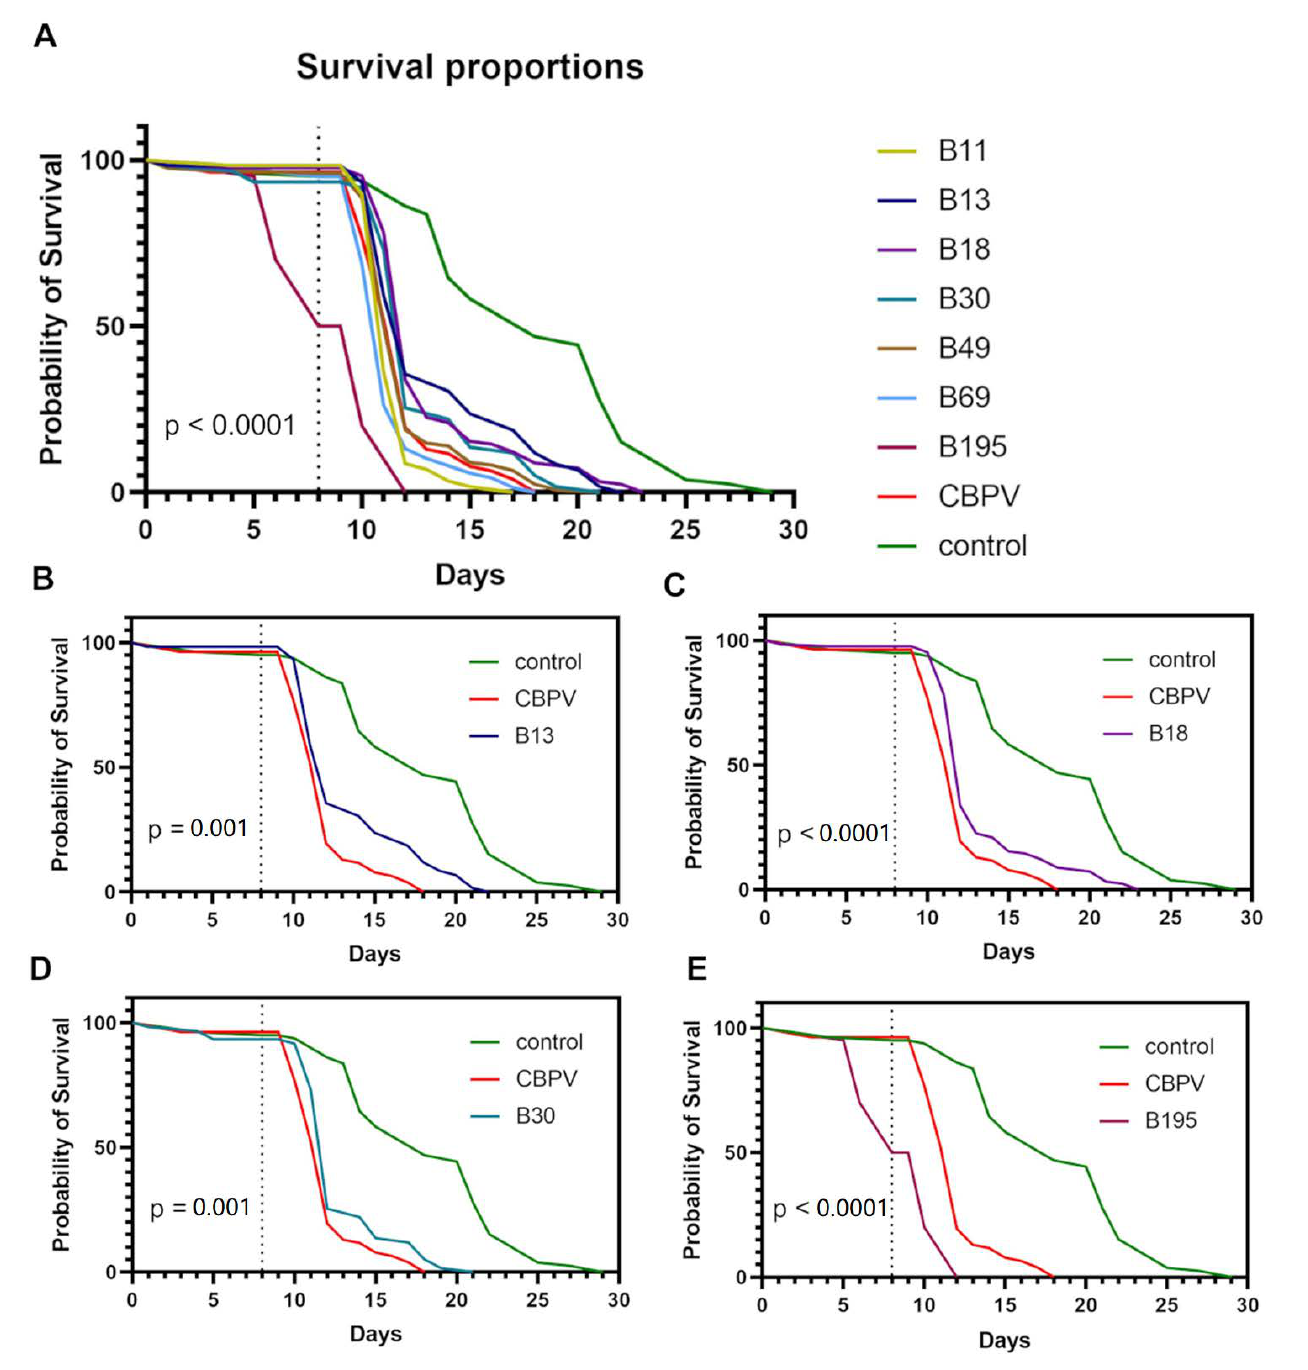
Figure 4. Survival proportions of bees fed on sugar solution containing fungal extracts or solvent (80% acetone) followed by the injection of CBPV or mock infection (control). The dotted line denotes the day of CBPV injection. The top graph shows the results for all seven extracts ( A ). For clarity, the extracts with significant effects are also shown in separate graphs ( B – E ), with the exception of B69, which was only just below the significance threshold ( p =